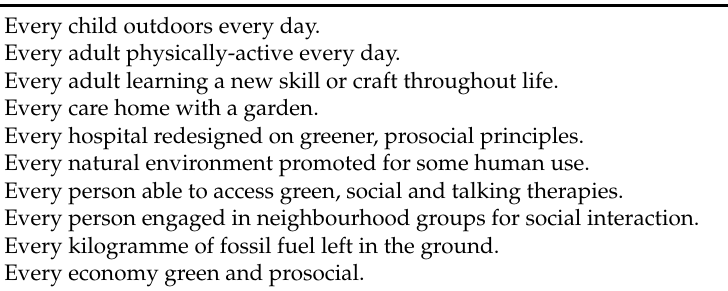
Table 4. Ten calls to action for the green